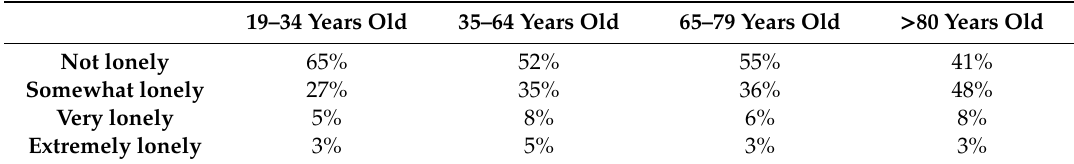
Table 1. Loneliness in Almere (2016)